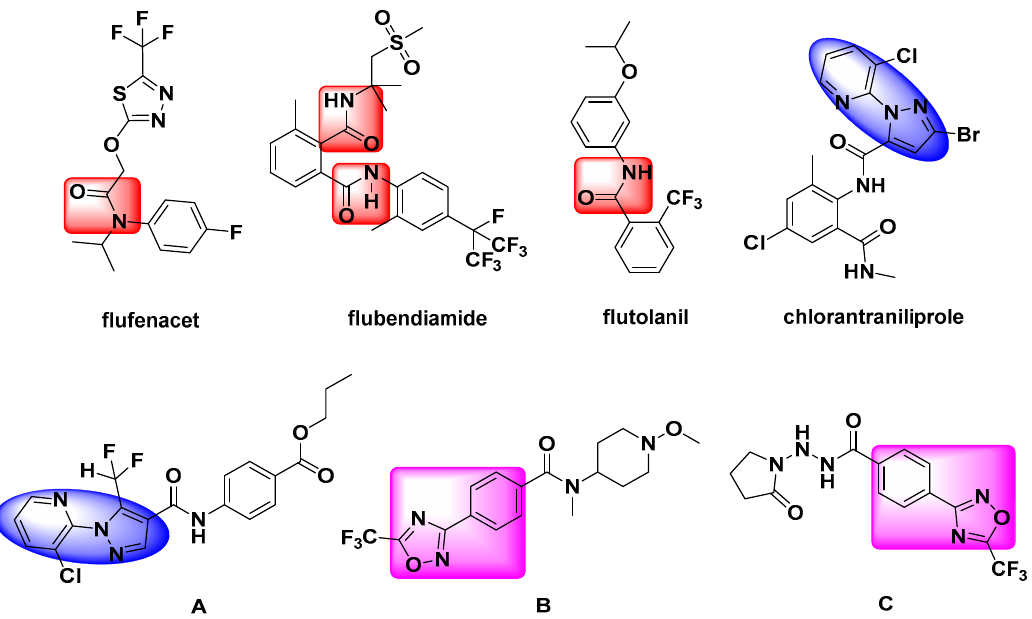
Figure 1. Chemical structures of flufenacet, flubendiamide, flutolanil, chlorantraniliprole and compounds A , B , C .